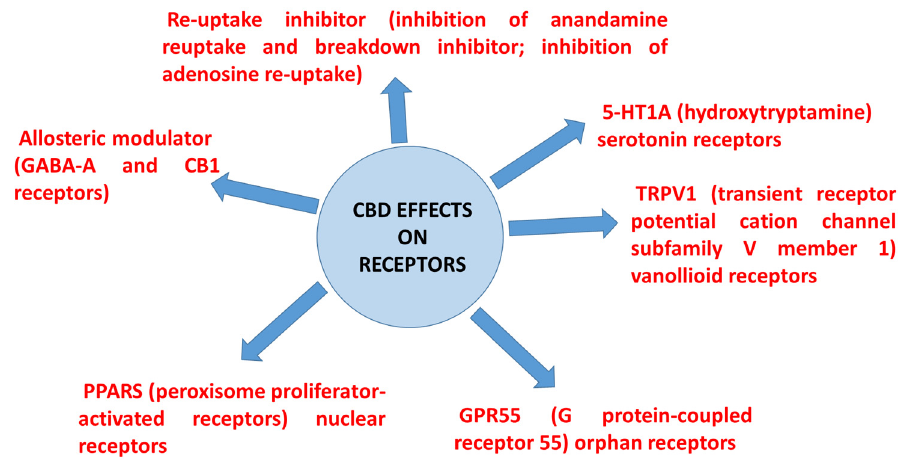
Figure 2. CBD effects on some receptors in addition to CB1 and CB2 receptors.